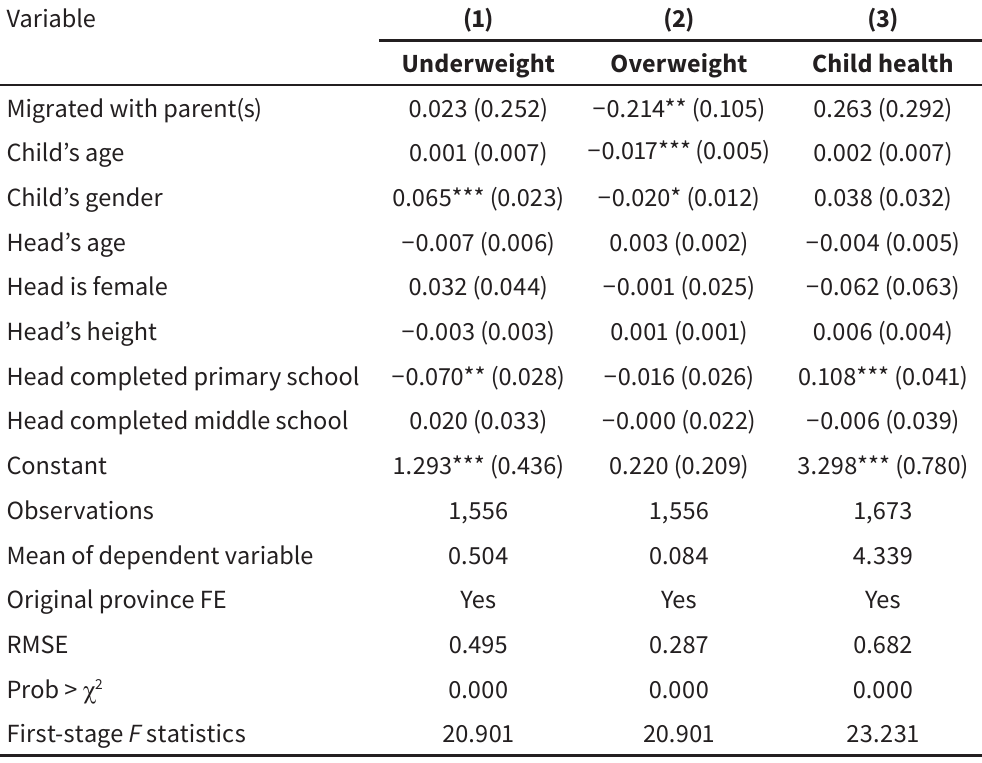
Child migration and well-being, China 2008